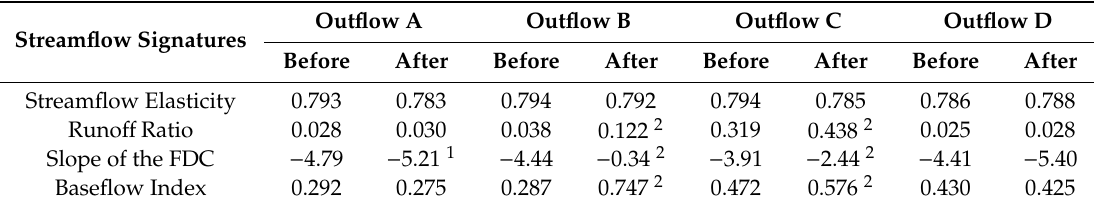
Table 7. Mean streamflow signature values for the before and after urbanization period by watershed. Footnotes indicate the p -value of trend analysis over the study